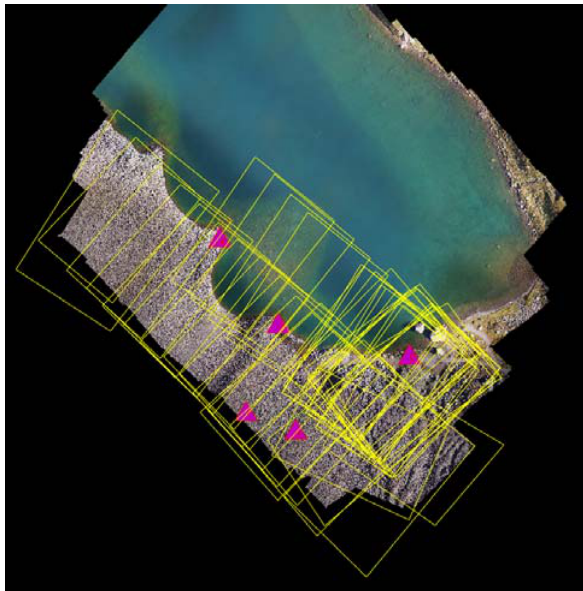
Figure 6: Reduced image block processed in multimedia- bundle.